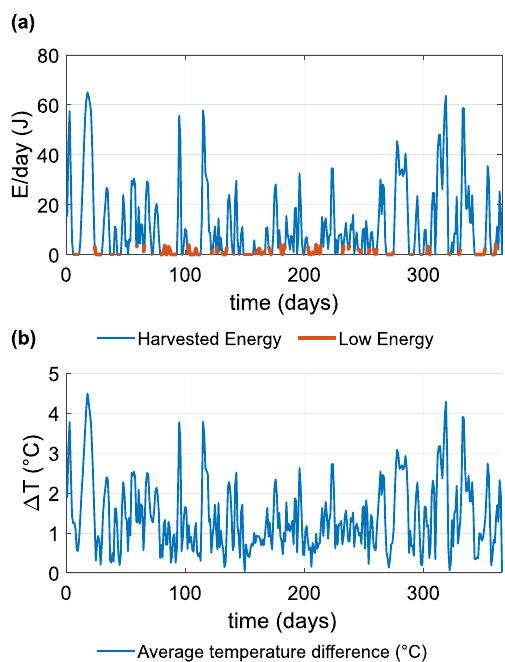
Figure 14. ( a ) Graph of daily harvested energy over the course of one year, where the quantity of harvested energy less than the median of harvested energy (4.82J) is indicated as Low Energy; ( b ) graph of the average daily temperature difference on the